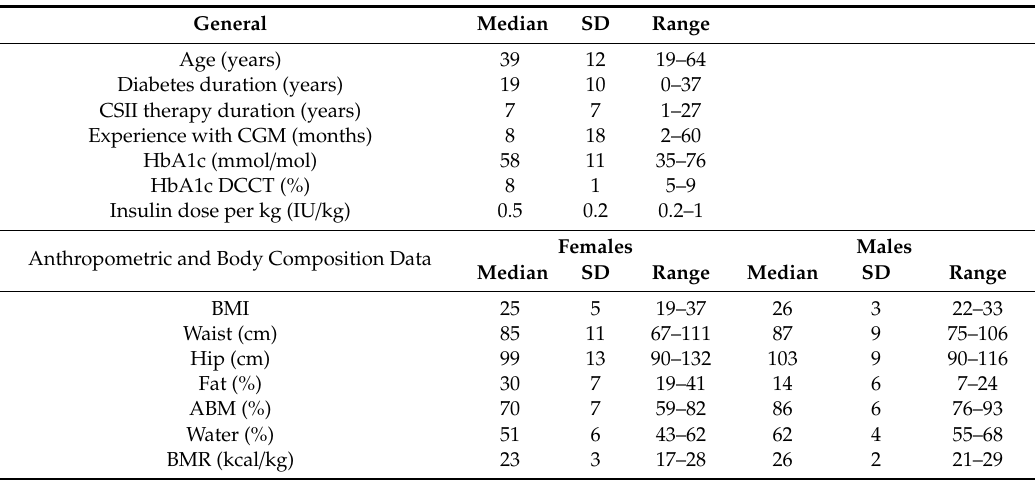
Table 1. group characteristics.